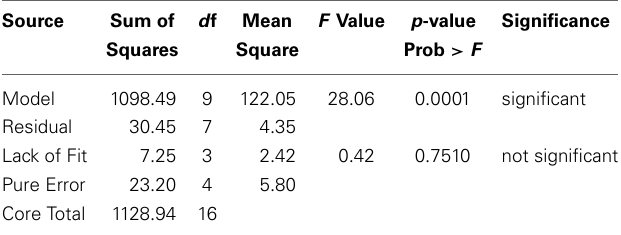
Table 8 | Summary of ANOVA for response surface quadratic model for the antibacterial activity using